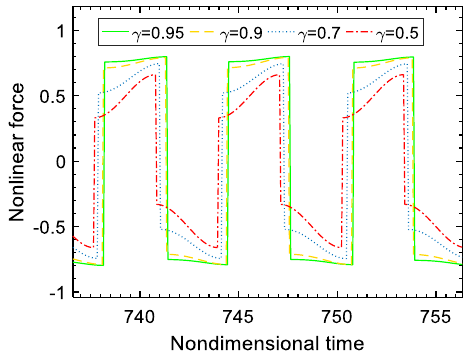
Figure 11. Nonlinear force curves in different γ net s.